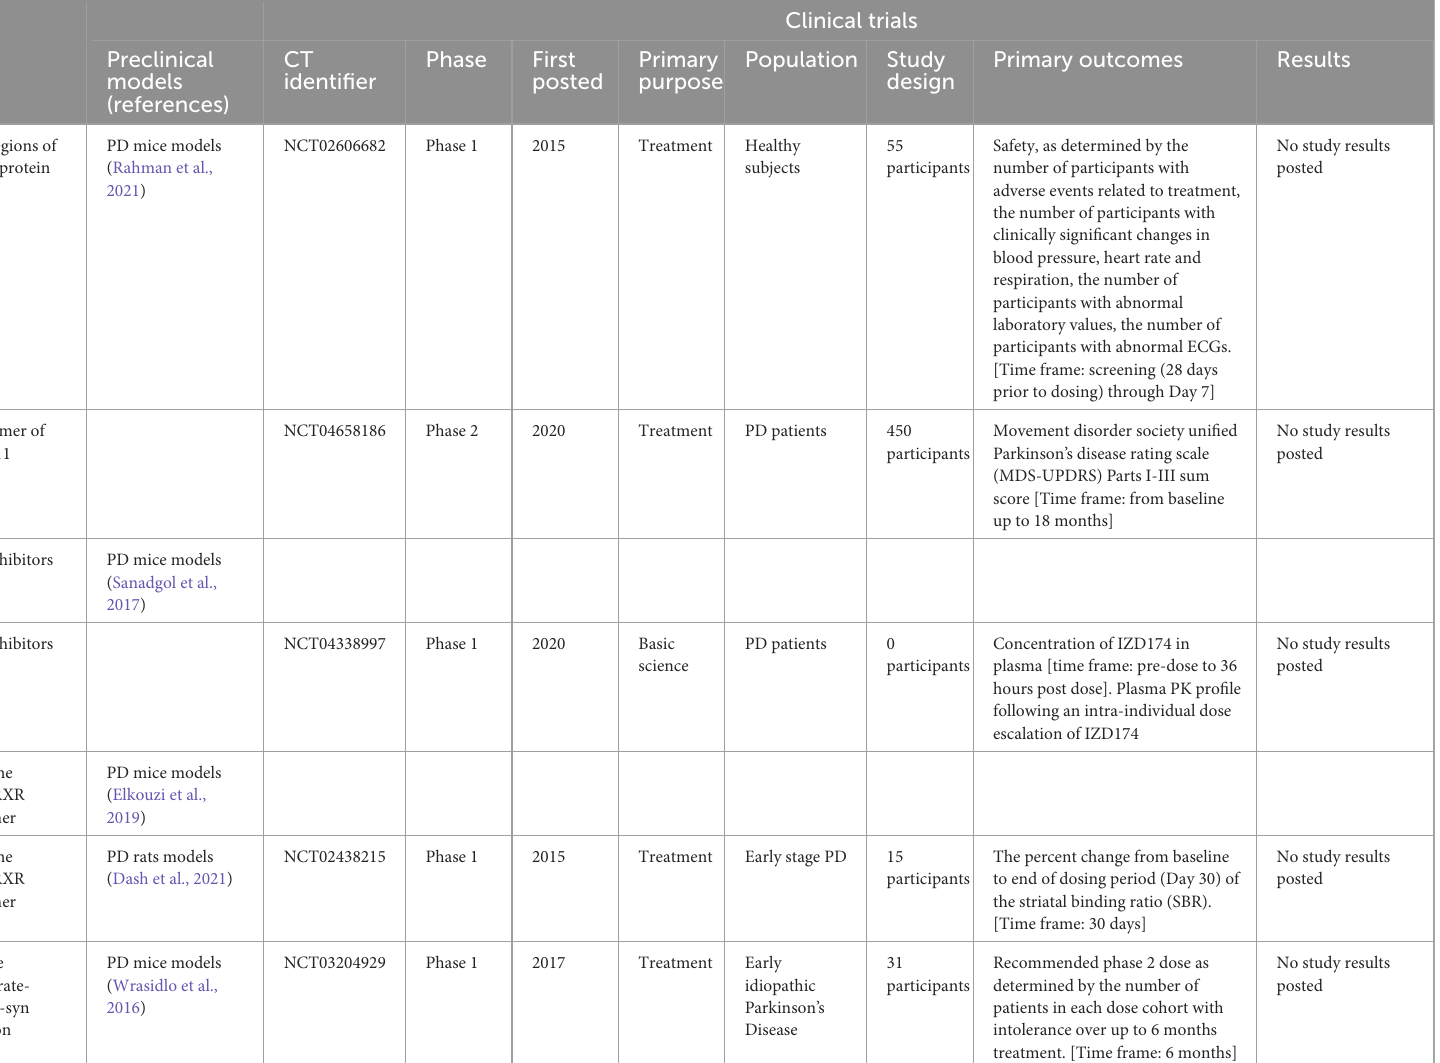
TABLE 1 Description of synthetic small molecules used in Parkinson’s disease or Huntington’s